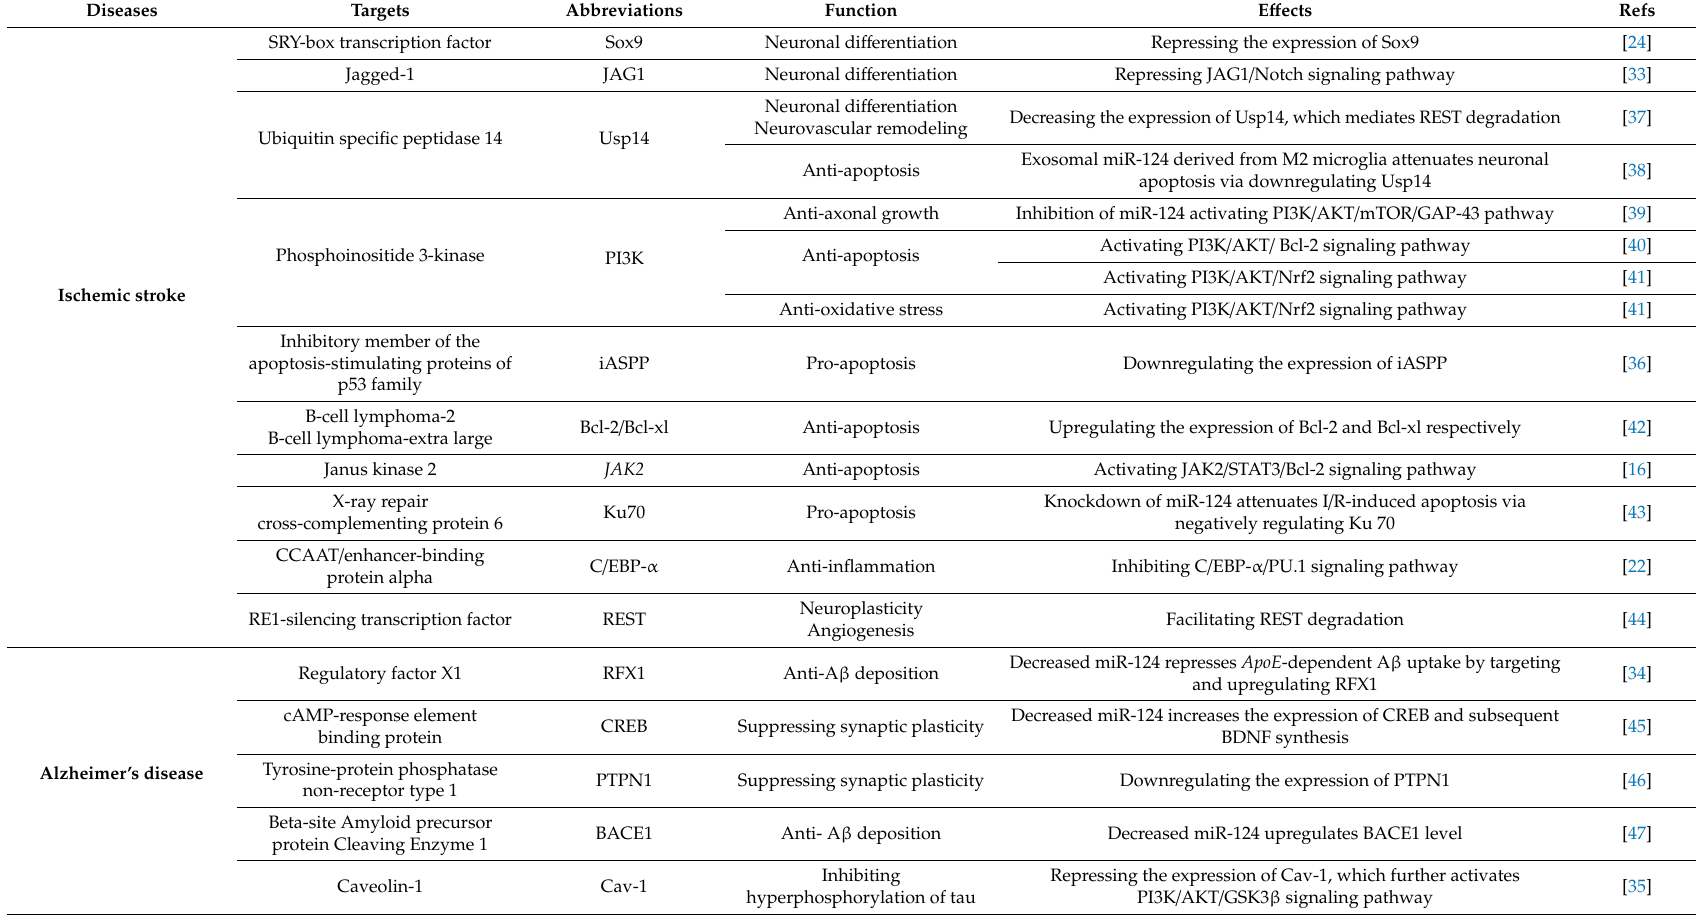
Table 1. Possible targets of microRNA-124 in ischemic